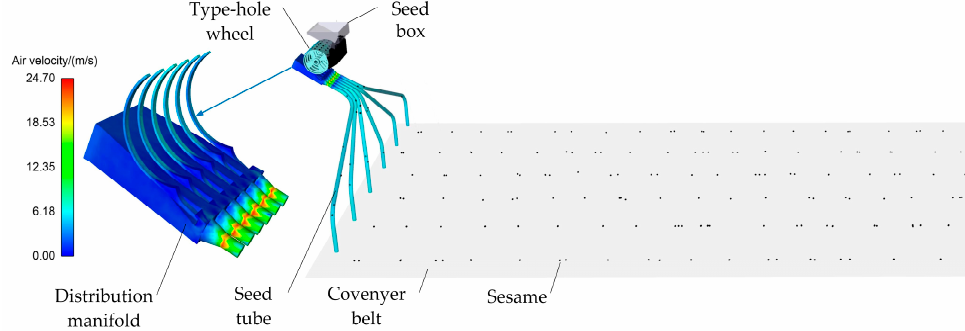
Figure 8. ( a ) Calibration process of Poisson’s ratio and shear modulus; ( b ) calibration process of coefficient of restitution.